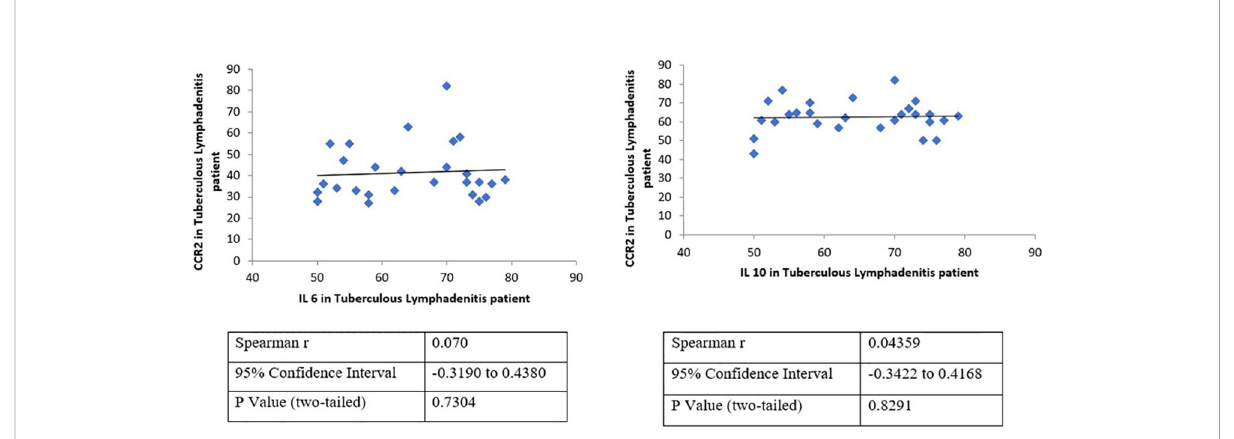
FIGURE 4 Correlation analysis validates the association between the expression of CCR2 and IL-6 or IL-10 in tuberculous lymphadenitis patients. A positive correlation between CCR2 – IL-6 and CCR2 – IL-10, which was never reported before for tuberculous lymphadenitis patients, has been demonstrated. However, the correlation of CCR-2 and CCL-5 was statistically insigni fi cant. CCR-2 has strong statistical correlation to IL-6 (p = 0,73) and IL-10 (p =